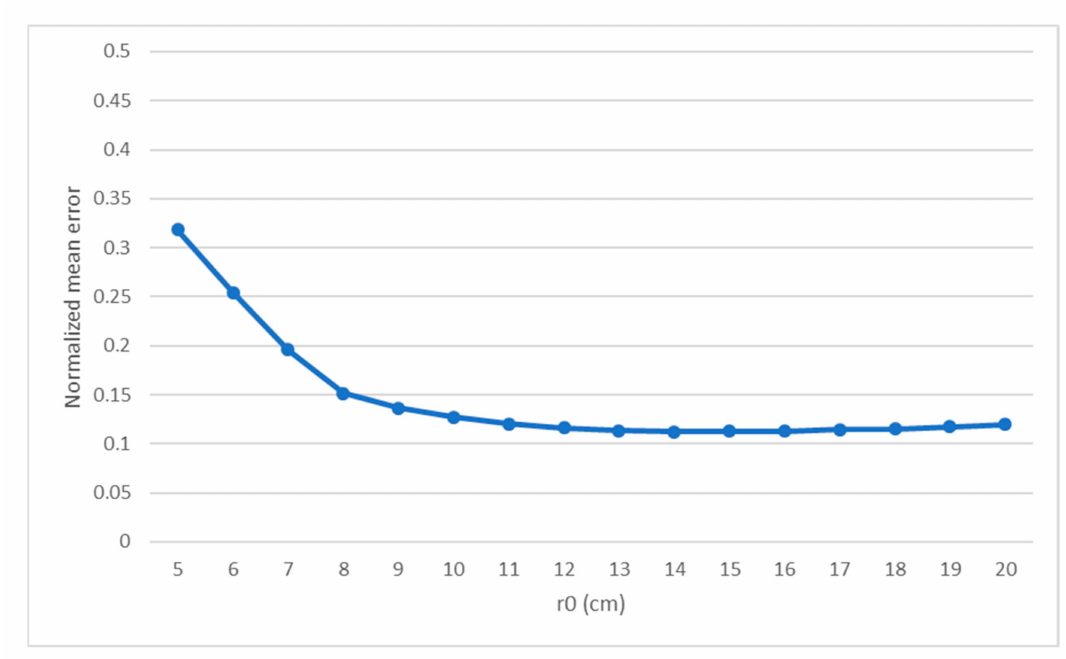
Figure 7. Normalized mean error for the tests varying the r 0 from 5 cm to 20 cm.